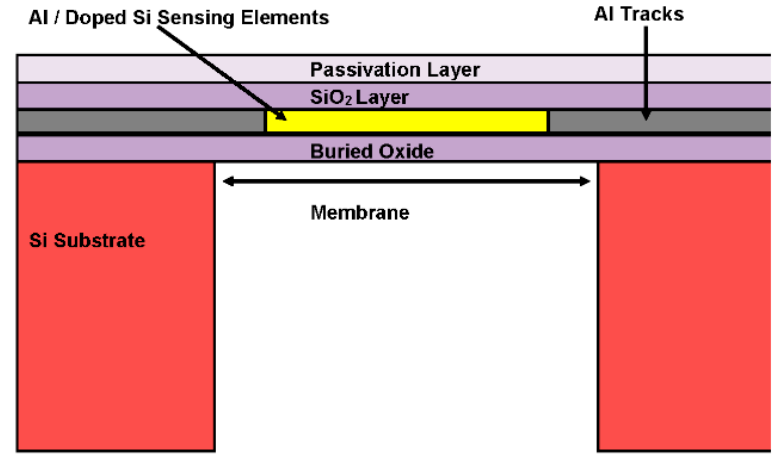
Figure 2. Design of thin silicon oxide membranes realized through DRIE in the SOI CMOS multi-sensor MEMS chip. The Buried Oxide Layer (BOX) layer acts as an effective etch stop for the DRIE process.